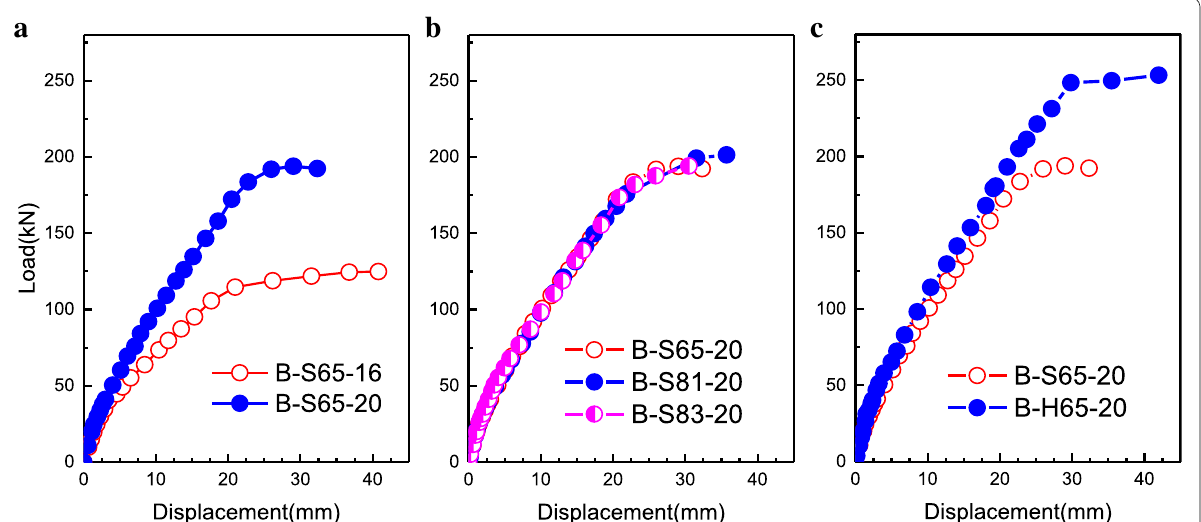
Fig. 11 Load mid-span displacement curves of the specimens: ( a ) different reinforcement ratios; ( b ) different fiber lengths; ( c ) different fiber